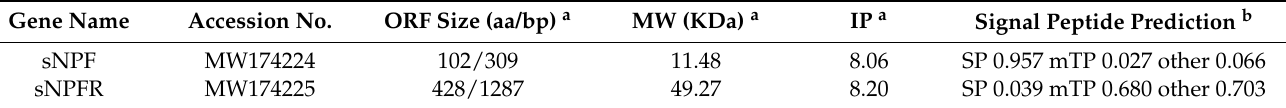
Table 1. Physicochemical properties and cellular localization of putative D. armandi sNPF and sNPFR proteins. Gene Name Accession